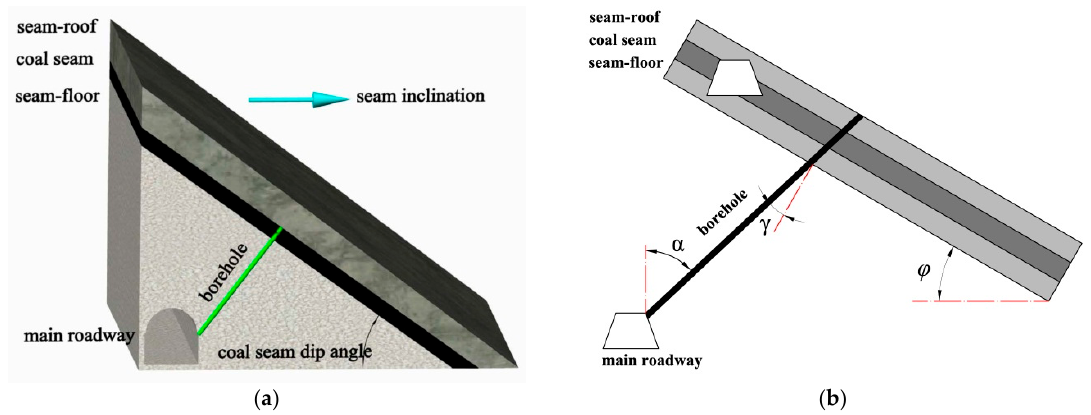
Figure 1. Diagram showing the relative positions of a hydraulic fracture borehole and a coal seam. ( a ) Graph showing a 3D view of hydraulic fracture; ( b ) graph showing a profile view of hydraulic fracture borehole from the seam inclination direction.